Question: Looking at the figure, what chart type is it?
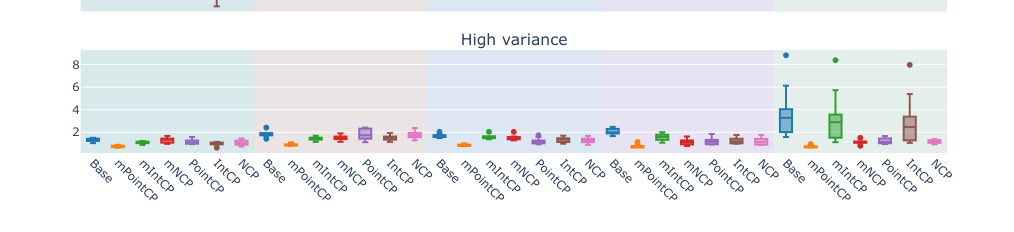
Answer: line